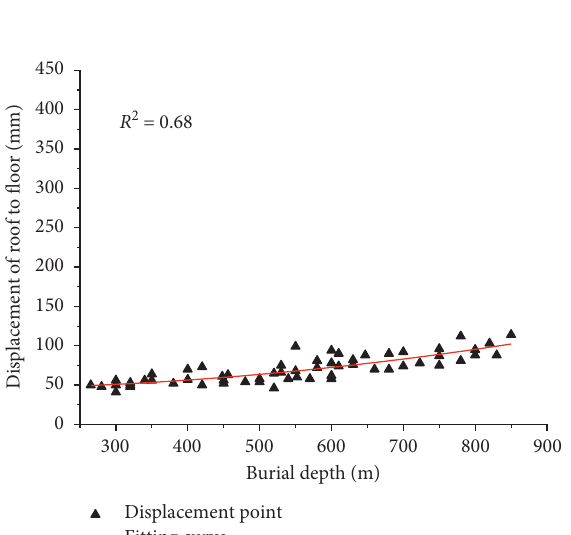
Figure 17: 80m away from the working face.